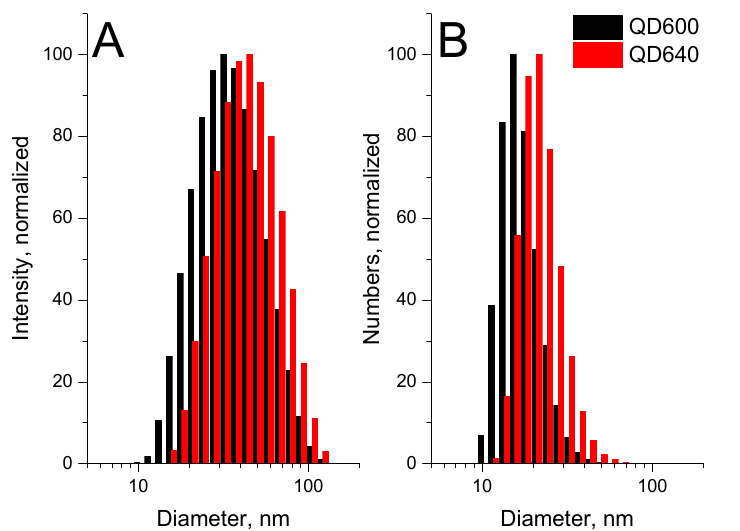
Figure A3. Size distribution of QD600 and QD640, obtained by the DLS method. ( A ) Initial data based on the scattered light intensity; ( B ) recalculation taking into account the dependence of the scattered light intensity on the size of the scattering particle.